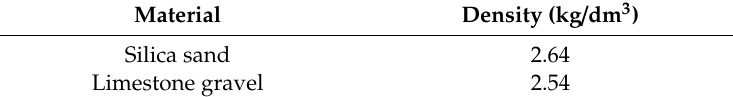
Table 1. Cement chemical composition (%wt.).